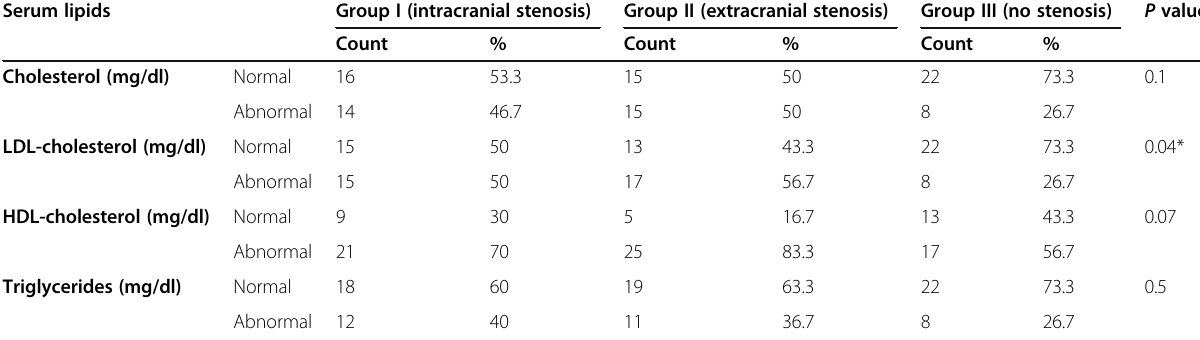
Table 2 Comparison of frequency of abnormal lipid profile between patients groups Serum lipids Group I (intracranial stenosis) Cholesterol (mg/dl) LDL-cholesterol (mg/dl)